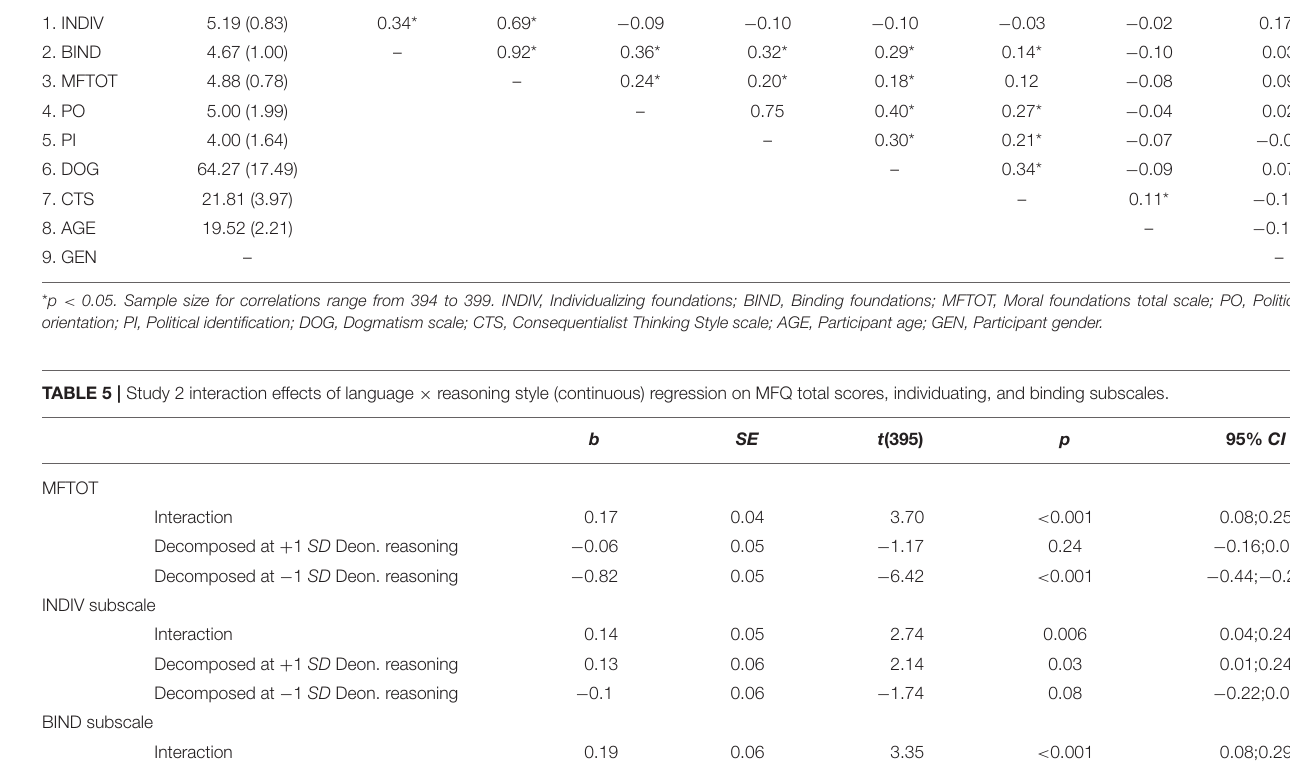
TABLE 4 | Study 2 means, standard deviations, and correlations of the variables. M ( SD )